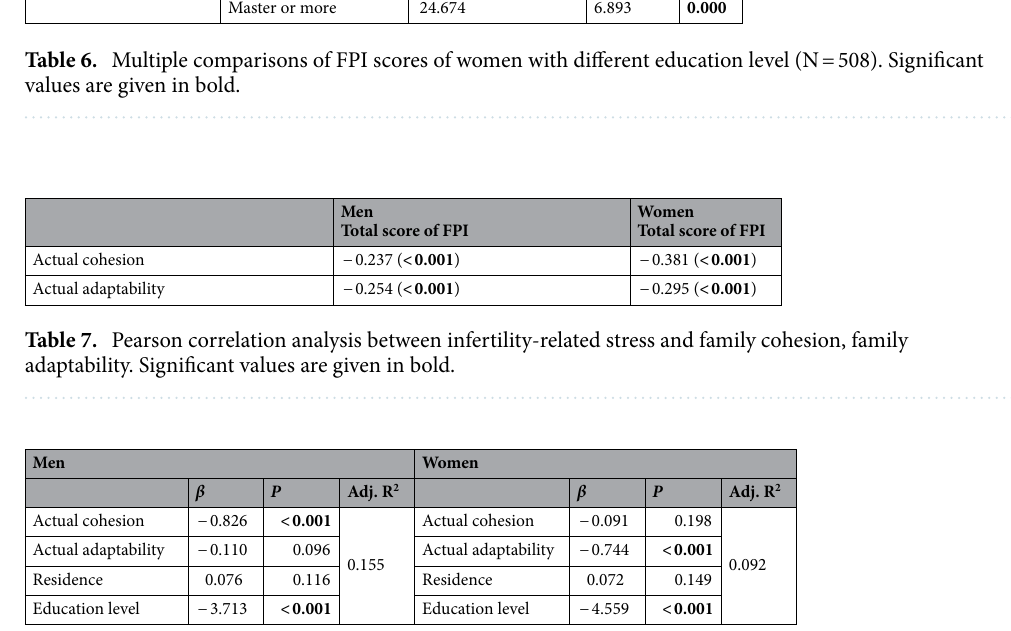
Table 8. Multiple regression analysis of infertility-related stress in infertile couples. Significant values are given in bold.